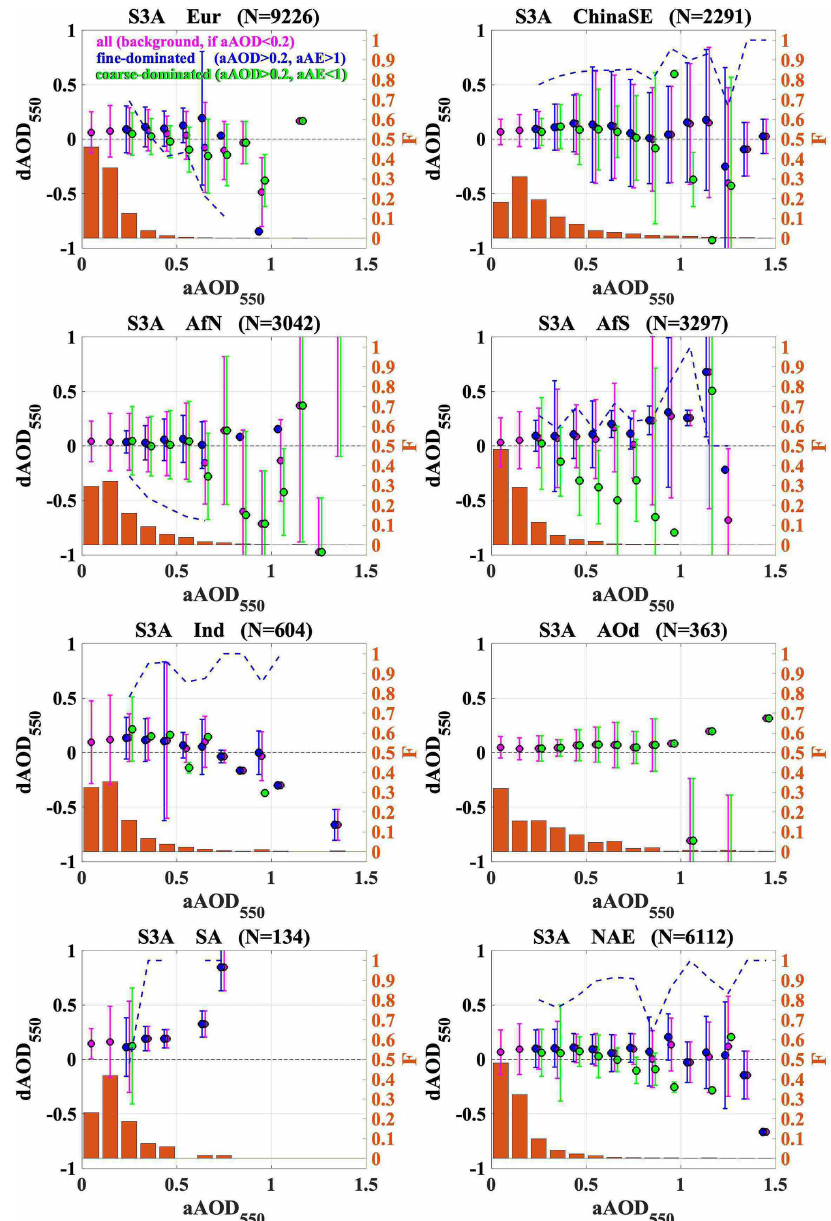
Figure 8. Regional (for Eur, ChinaSE, AfN, AfS, Ind, AOd, SA, NAE) difference (dAOD 550 ) between syAOD and aAOD for aAOD binned in 0.1 intervals: median bias (circles) and bias standard deviation (error bars) for all and background (aAOD ≤ 0.2) AOD types (purple), as well as aerosol fine-dominated AOD (blue) and coarse-dominated AOD (green). The fraction ( F ) of points in each bin from the total number of matchups is represented by orange bars. The fraction of fine-dominated matchups in each bin is shown as a blue dashed line. Results for other regions are in the Supplement (Fig.